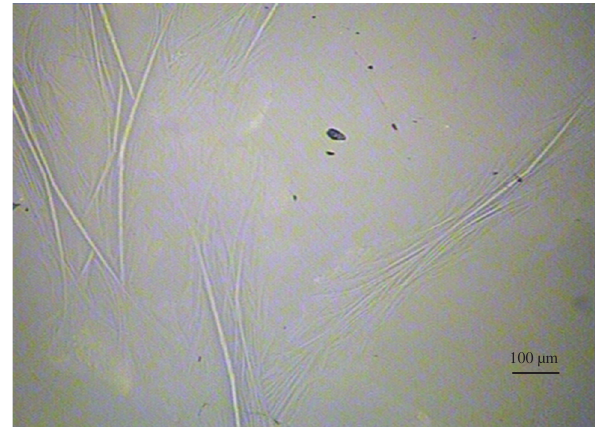
Figure 2: Optical microscopic of the quenched slag at 1,723 K.